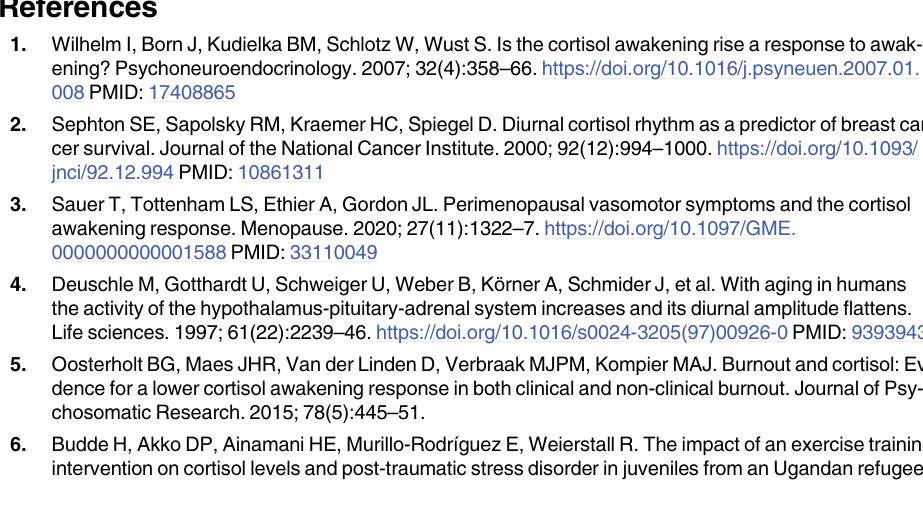
S12 Table. Differences in the changes of TG and BDNF depending on BMI groups through the marine healing program. Each bar represents the mean ± SD. p-values were obtained by student t-test. * p-value < 0.05; ** p < 0.01. TG: triglyceride; BDNF: brain-derived neurotrophic